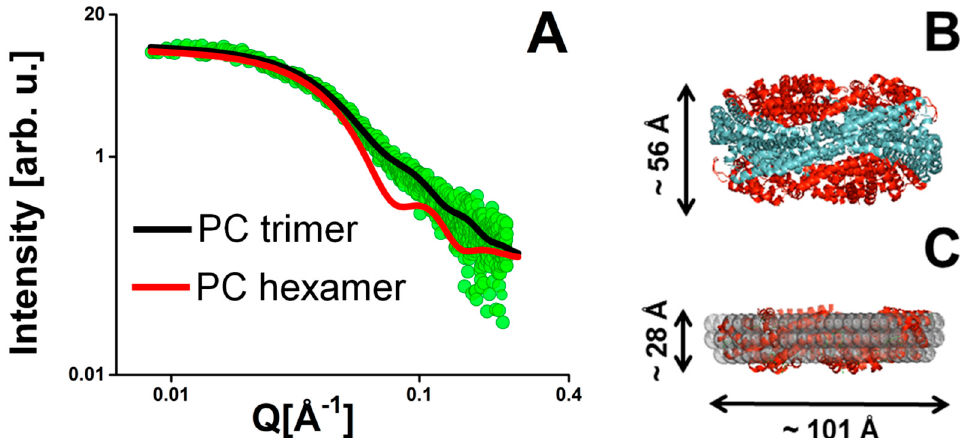
Figure 1. Panel ( A ): SAXS data of phycocyanin (PC) from T. elongatus obtained on Nanostar (green circles) at room temperature. The full black and red lines are fits based on the structures trimeric (black line) and hexameric PC (red line) using the program package CRYSOL. Panel ( B ): Crystal structure of PC from T. elongatus in hexameric form based on PDB code 4ZIZ [54]. Panel ( C ) Crystal structure of PC from T. elongatus in trimeric form based on PDB code 4Z8K [55]. The grey spheres in Panel C show the low-resolution structure of PC obtained using the program ATSAS from the SAXS data shown in Panel ( A ). Graphics taken from Golub et al. BBA 2017 [61] with permission.